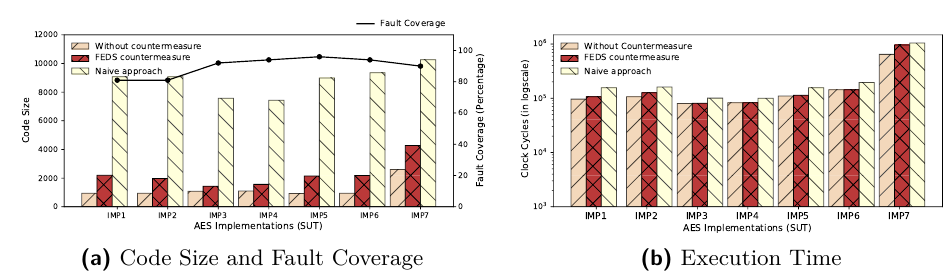
Figure 12: Comparison of unprotected implementations, naïvely protected implementations with FEDS based automatic protection. The graph also shows the fault coverage, which is same for both approaches. Results are taken from a 64-bit Ubuntu 16.04 Linux machine on a quad-core Intel i5-3340 CPU @